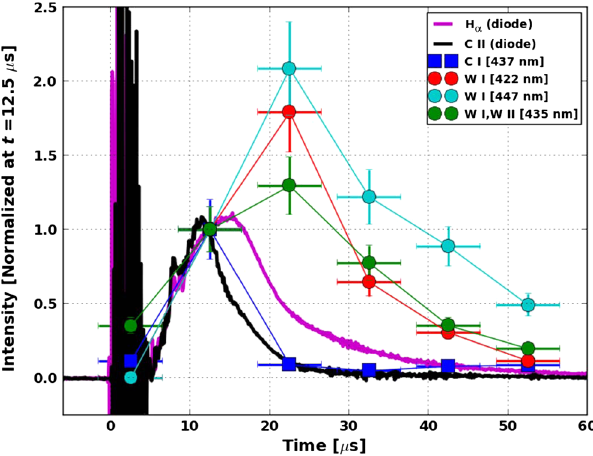
FIG. 10. Temporal variation of plasma line emission intensities, from ensemble of six plasma shots. The magenta lines and black lines are the average filtered photodiode signals for hydrogen α and carbon ion lines. It is noted that the diode signals have less than a 10% variation from shot to shot.